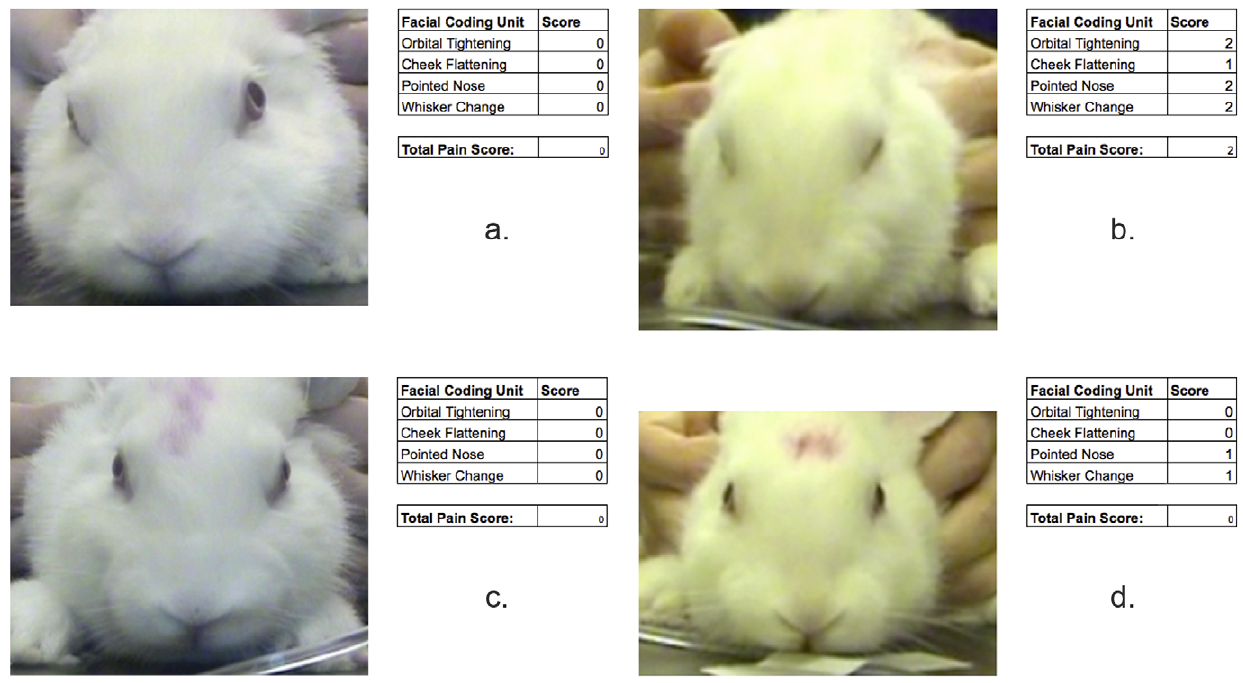
Figure 6. Example images and RbtGs scores. Example images and associated RbtGS scores of a rabbit in the pre-tattoo (a) and intra-tattoo (b) periods without prior application of EMLA and of a rabbit in the pre-sham tattoo (c) and intra-sham tattoo (d) periods without prior application of EMLA.